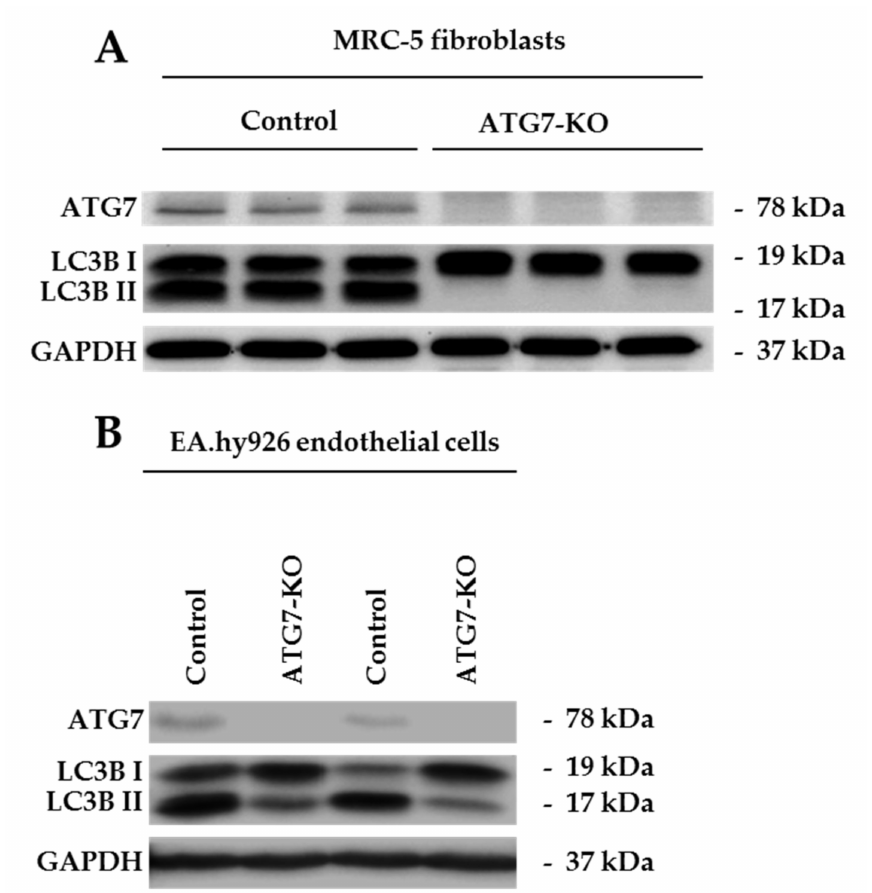
Figure 1. Western Blot analysis of the ATG7-knockout (ATG7-KO) in endothelial cells and fibroblasts. ( A ) Western Blot of ATG7, LC3BI and II in control versus ATG7-KO-MRC-5 fibroblasts ( B ) Western Blot of ATG7, LC3BI and II in control versus ATG7-KO in EA.hy926 endothelial cells. 2.2. Autophagosomal Generation is Hampered in ATG7-Knockout Endothelial Cells, but not in Lung